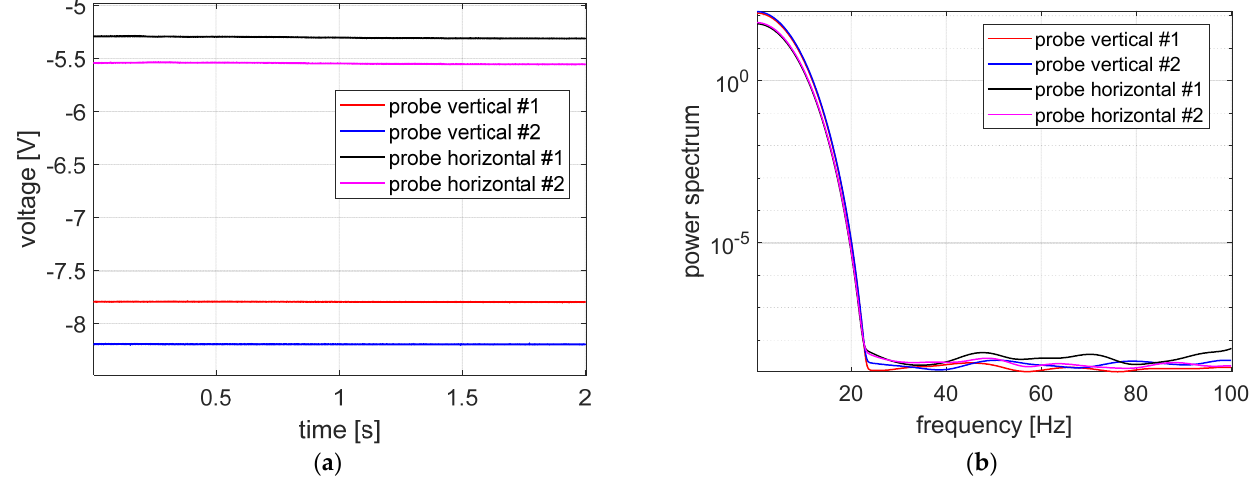
Figure 8. Measurement signals recorded with the power supply turned off for the magnetic bearings and the measuring sensors powered on: ( a ) time courses, ( b ) signal power spectrum.